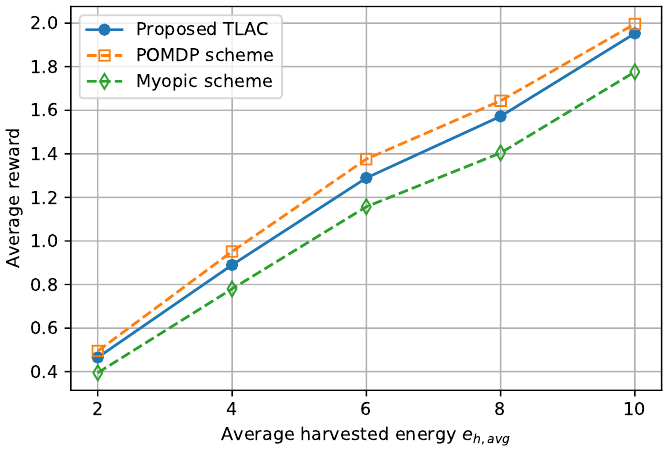
Figure 14. Average reward according to harvested energy for different data protection schemes. POMDP: partially observable Markov decision